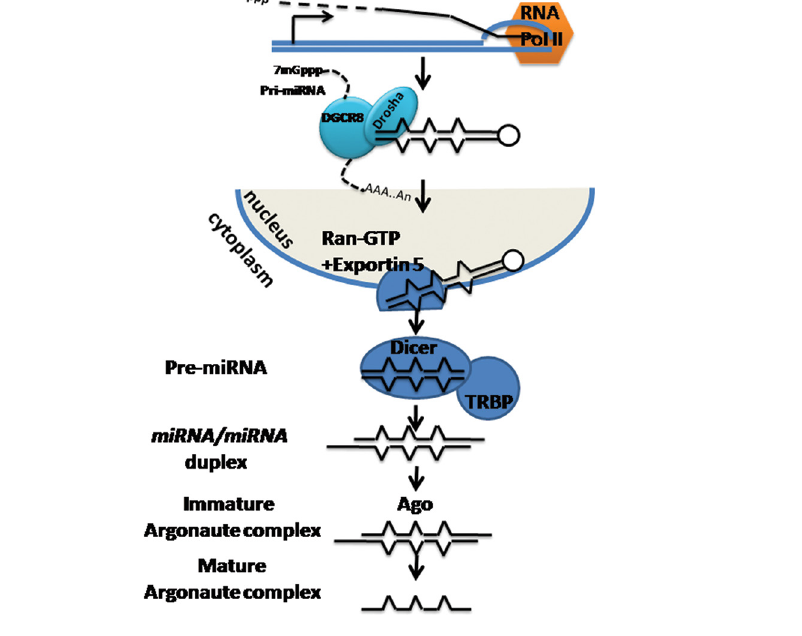
Figure 3. Argonaute proteins in the RISC-miRNA complex helps in conversion of precursor miRNA to mature miRNA. Abbreviations: AGO, Argonaute; GTP, guanidine 5 ¢ triphosphate; Pol II, polymerase II; TRBP, transactivation-response-RNA binding protein. In the cytoplasm, the miRNA duplex is associated with Argonaute proteins of the RISC-miRNA complex. One of the strands of miRNA duplex, referred to as a guide strand, is retained in the AGO to form miRNA-induced silencing. Figure reproduced with permission of Elsevier. Matranga C, Zamore PD. (2007) Small silencing RNAs. Curr. Biol. 17:R789–R793. (cited as reference [47] in the current